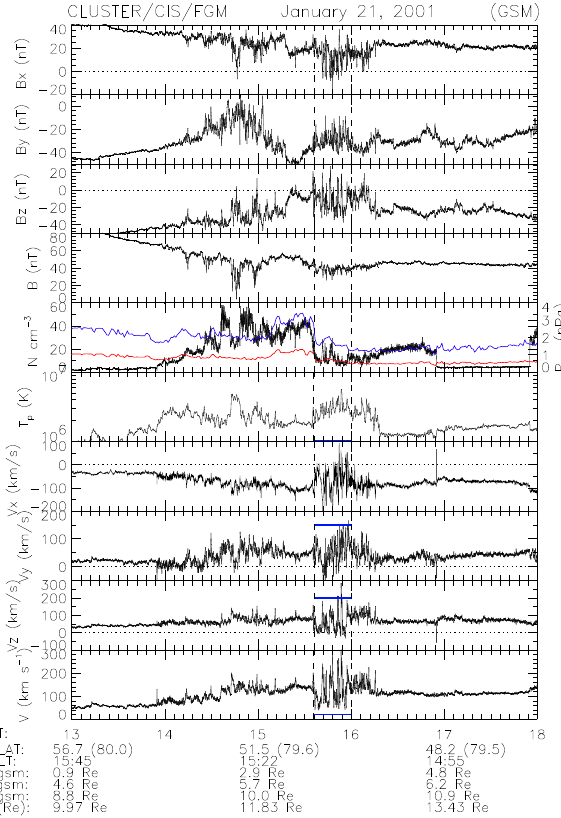
the magnetic field components in GSM coordinates and total field, the proton plasma density, temperature, flow components and total flow speed. The density panel shows the solar wind density (red) and dynamic pressure (violet), properly time-shifted. The main in- terval of study (15:36–16:00 UT) is shown between vertical guide-